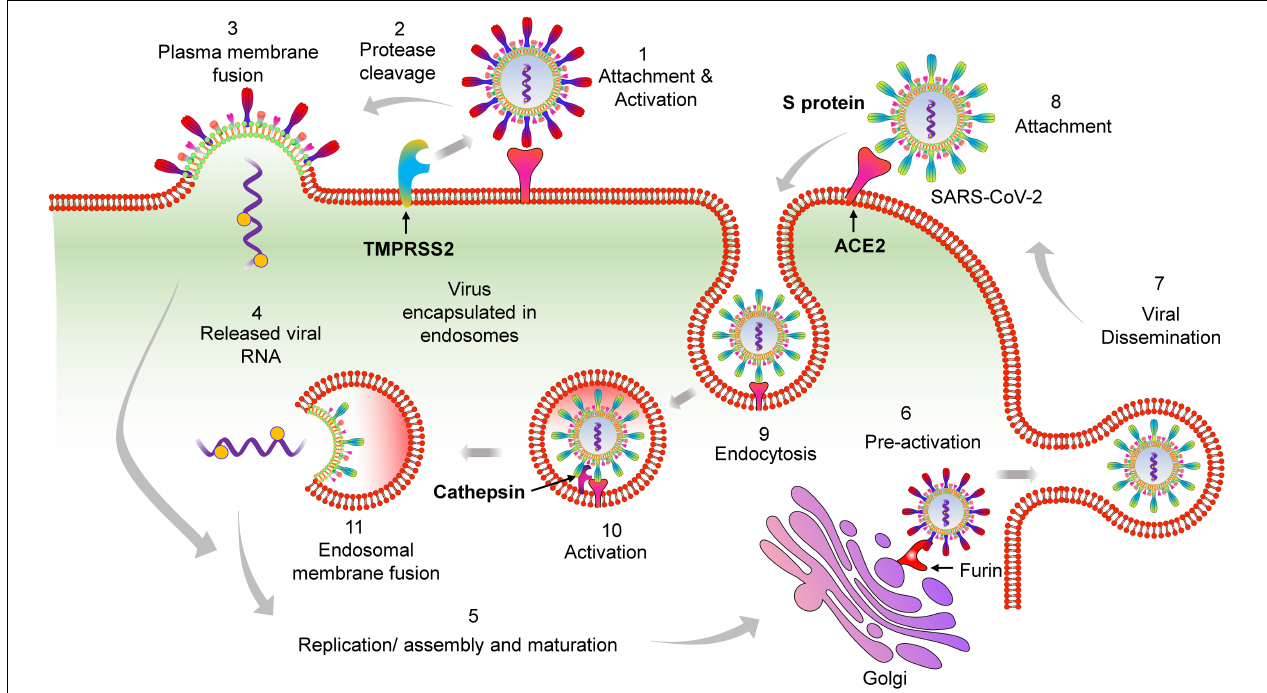
FIGURE 1 | Proposed model of SARS-CoV-2 entry into the host cells. Based on available literature on SARS-CoV and recent findings on SARS-CoV-2, we suggest two different mechanisms that can be employed by SARS-CoV-2 to enter into the ACE2 expressing cells. (1) Initially the virus may use the cell membrane mode of entry. The first step is the binding of the spike protein of the virus with ACE2 receptors expressed on the plasma membrane of host cells. (2) The attachment with ACE2 is followed by the cleavage of S protein by membrane bound proteases like TMPRSS2. TMPRSS2 cleaves the membrane bound virus at both S1/S2 boundary as well as at S2’ site. (3) This activates the fusion machinery, and subsequently, the viral membrane fuses with the host cell plasma membrane. (4) This leads to release of the viral nucleocapsid into the cytoplasm. (5) The replication, assembly, and maturation of virus takes places in the cytoplasm. (6) Before dissemination, SARS-CoV-2 may also undergo pre-activation in the golgi apparatus by furin proteases. (7) The fully mature and pre-activated SARS-CoV-2 eventually disseminates from host cells by exocytosis. During subsequent infection cycles, the virus may utilize either cell membrane or (8–11) the more probable endocytic entry route. In the endocytic mode of entry, (8) after attachment with ACE2, (9) the virus gets endocytosed and (10) then processed at the S2’ region by endosomal proteases like cathepsins, to activate membrane fusion. (11) Finally, the viral components are released into the cytoplasm by fusion of the viral membranes with endosomal membrane, leading to repeat of the